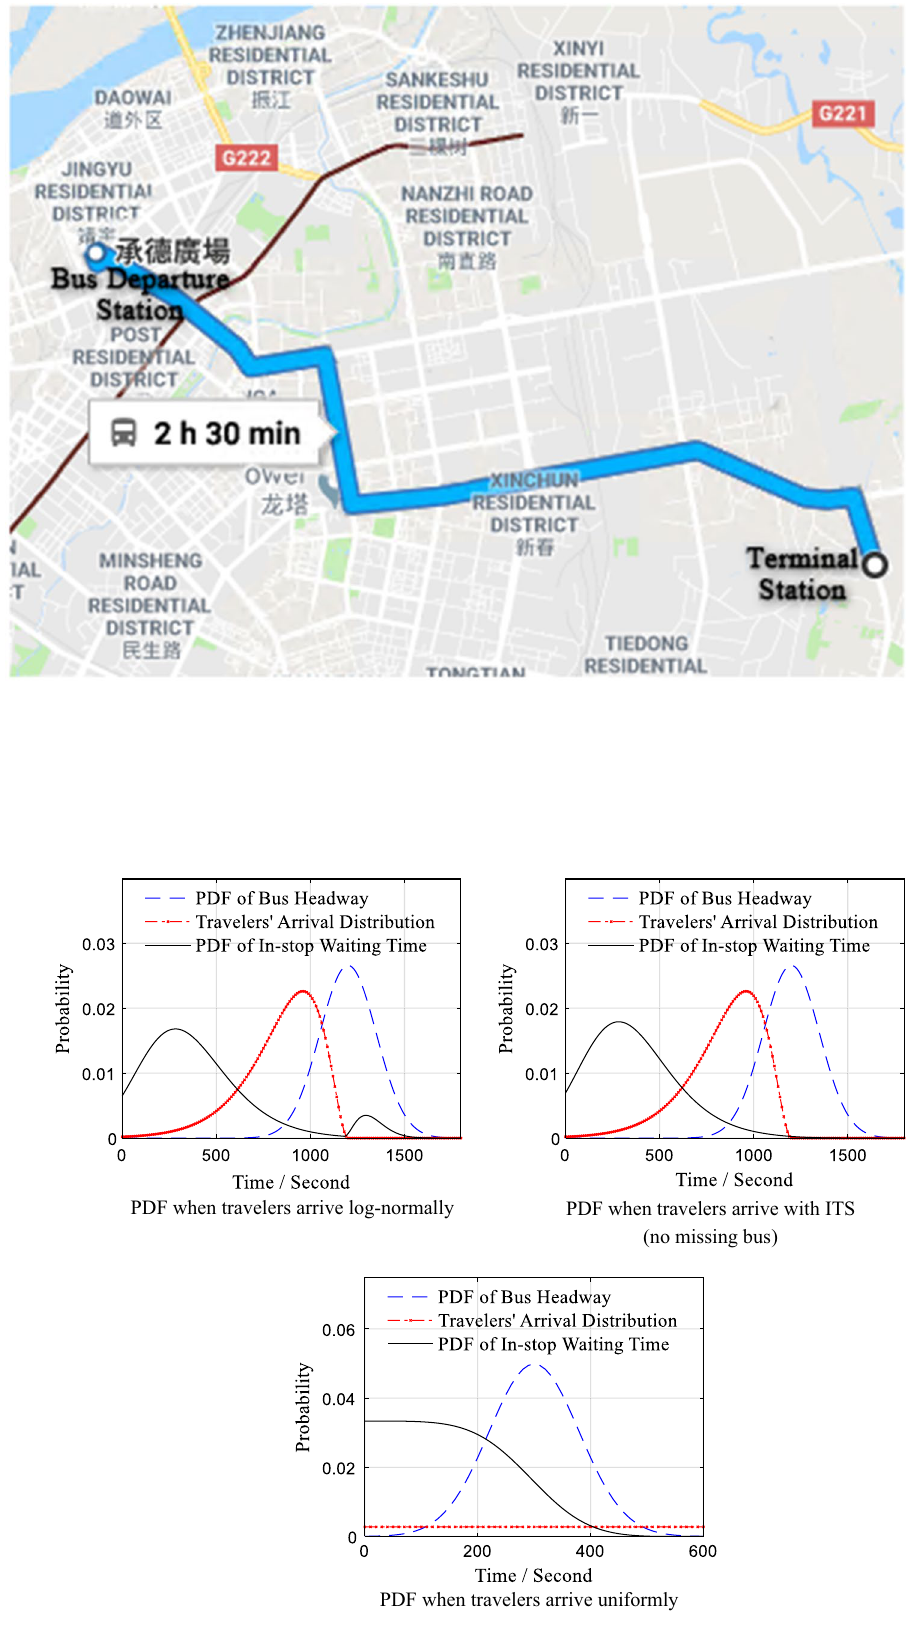
Fig. 9 Route of the No. 40 bus